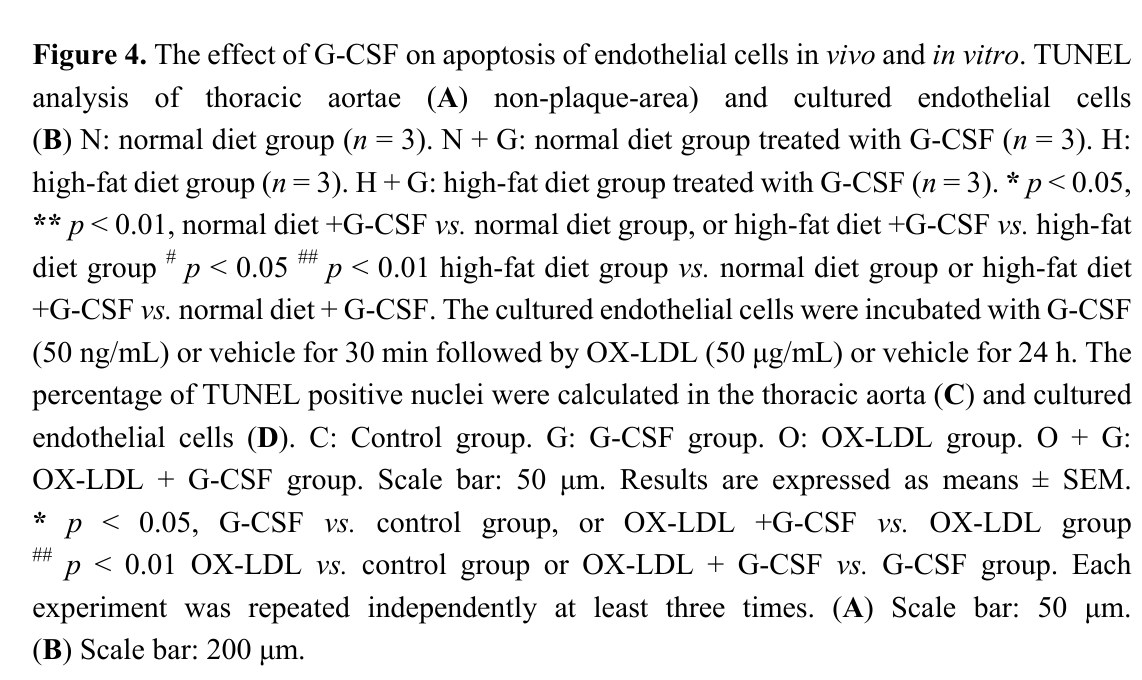
Figure 4. The effect of G-CSF on apoptosis of endothelial cells in vivo and in vitro . TUNEL analysis of thoracic aortae ( A ) non-plaque-area) and cultured endothelial cells ( B ) N: normal diet group ( n = 3). N + G: normal diet group treated with G-CSF ( n = 3). H: high-fat diet group ( n = 3). H + G: high-fat diet group treated with G-CSF ( n = 3). * p <